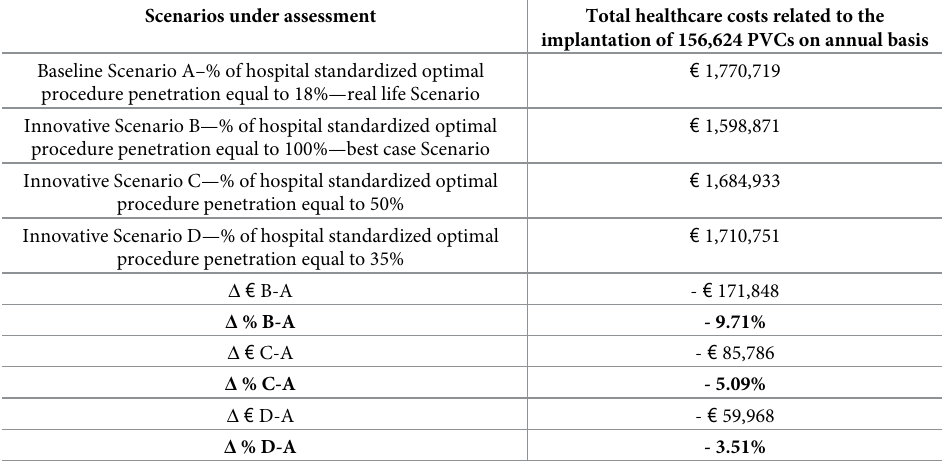
Table 7. Budget impact analysis.